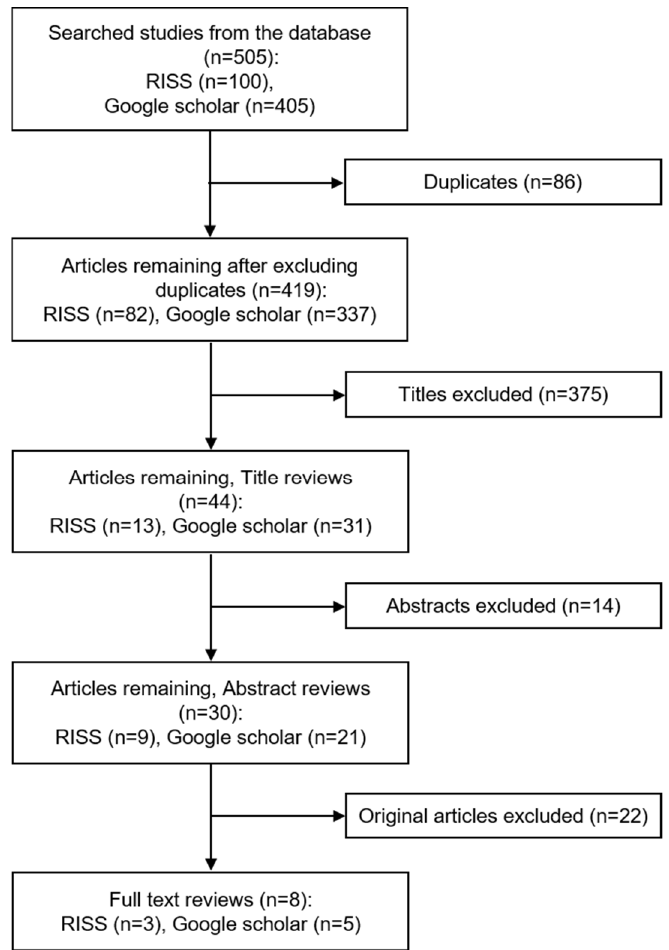
Figure 2. Flow of the Selection Process of Studies for Review.